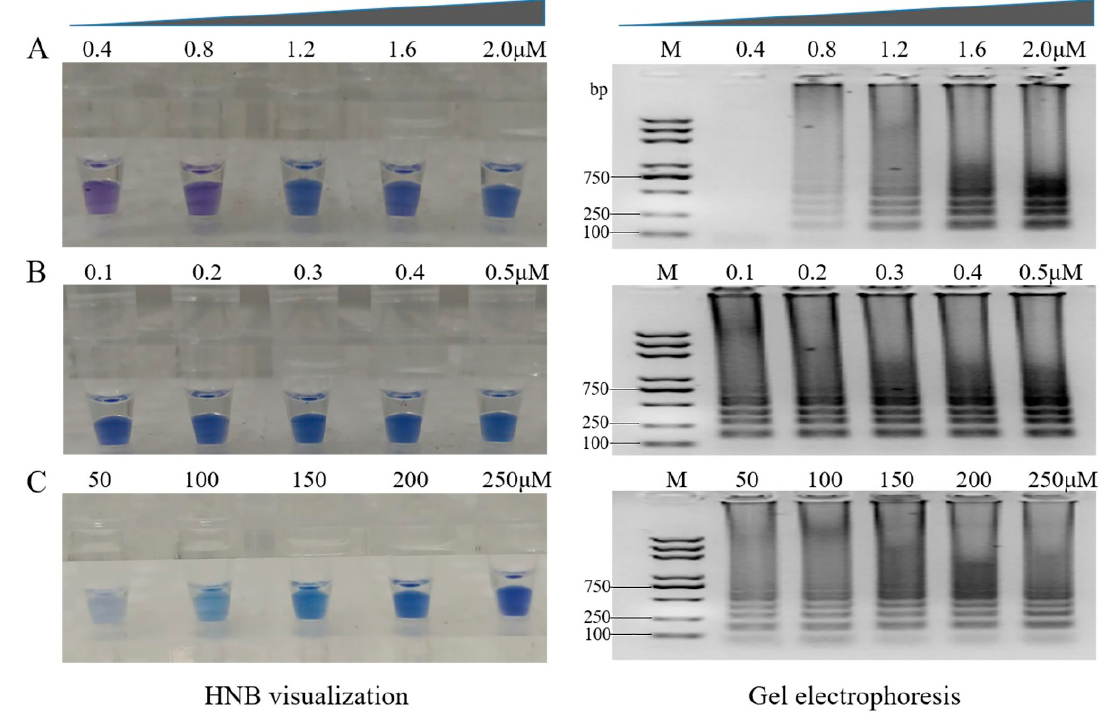
Figure 6. Optimization the concentrations of FIP/BIP ( A ), F3/B3 ( B ), HNB ( C ), respectively. M. Trans 2K Plus DNA marker.